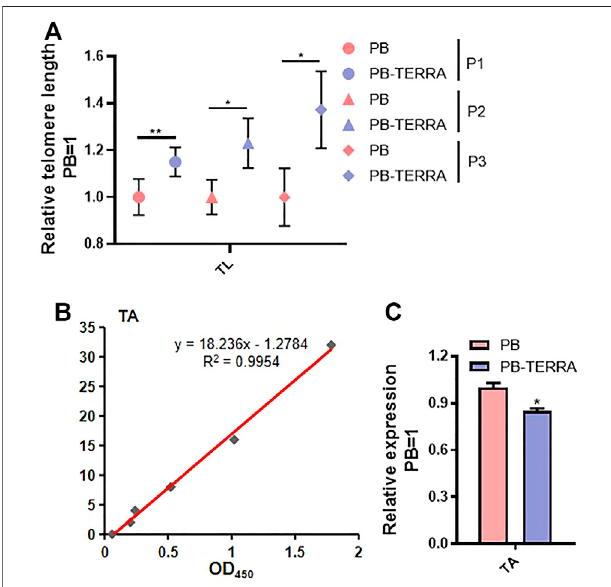
FIGURE3| TERRAwithpolyadenylationincreasestelomerelengthwhile inhibits telomerase activity in mESCs. (A) Relative telomere length (TL) of PB and PB-TERRA mESCs at different passages was measured by quantitative real-time PCR (qRT-PCR). P1: mESCs cultured for 1 passage. P2: mESCsculturedfor2passages.P3:mESCsculturedfor3passages.Relative TL were normalized against PB control. (B, C) Telomerase activity (TA) was detectable in PB and PB-TERRA mESCs by ELISA. (B) : Linear relationship between optical density (OD) at 450 nm and standard telomerase activity using a mouse telomerase ELISA kit. (C) : Relative telomerase activities compared in PB and PB-TERRA mESCs. Data were normalized to PB cells. (A, C) Data represent means ± SD of three biological replicates. * p < 0.05, ** p < 0.01 vs. PB.